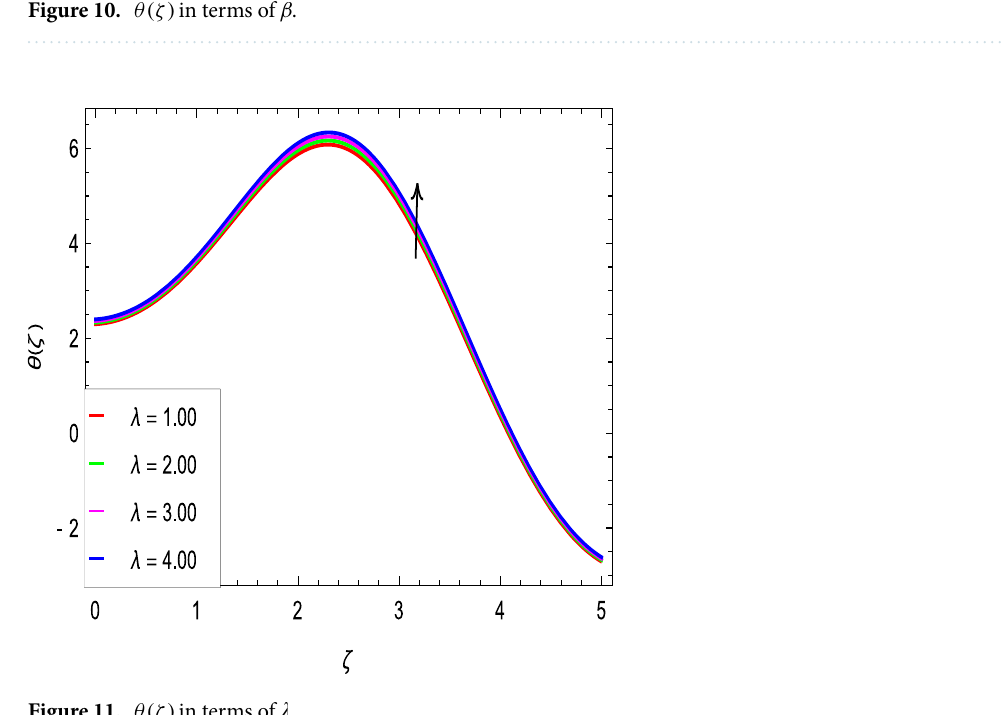
Figure 11. θ(ζ) in terms of (cid:31)